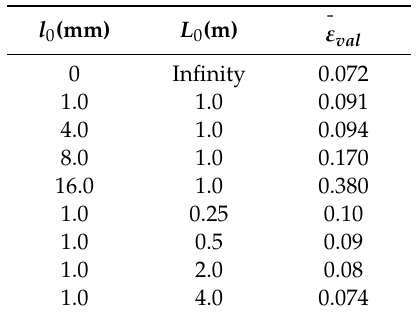
Table 5. Evaluation of turbulence inner l 0 and outer L 0 scales impact on averaged C 2 n prediction error ε val in the cross-dataset training-inference machine learning experiments with Cnˆ2Net training performed using the SIM-KO dataset (Kolmogorov turbulence model) and inference ( C 2 n prediction) using the SIM-VK datasets (Von Karman power spectrum model). The first row corresponds to the deep neural network (DNN) training and prediction using SIM-KO